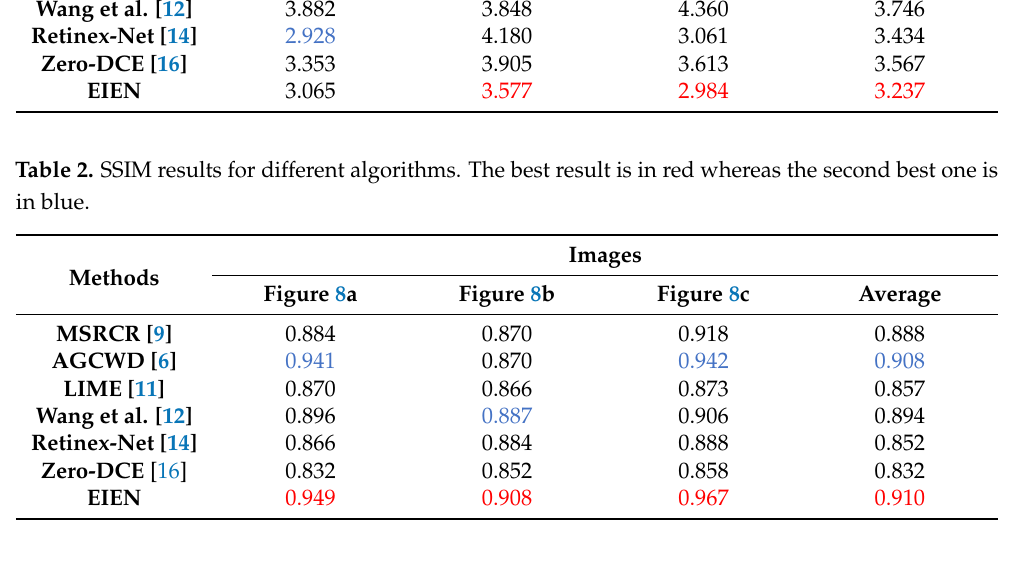
Table 3. GMSD results for different algorithms. The best result is in red whereas the second best one is in blue.